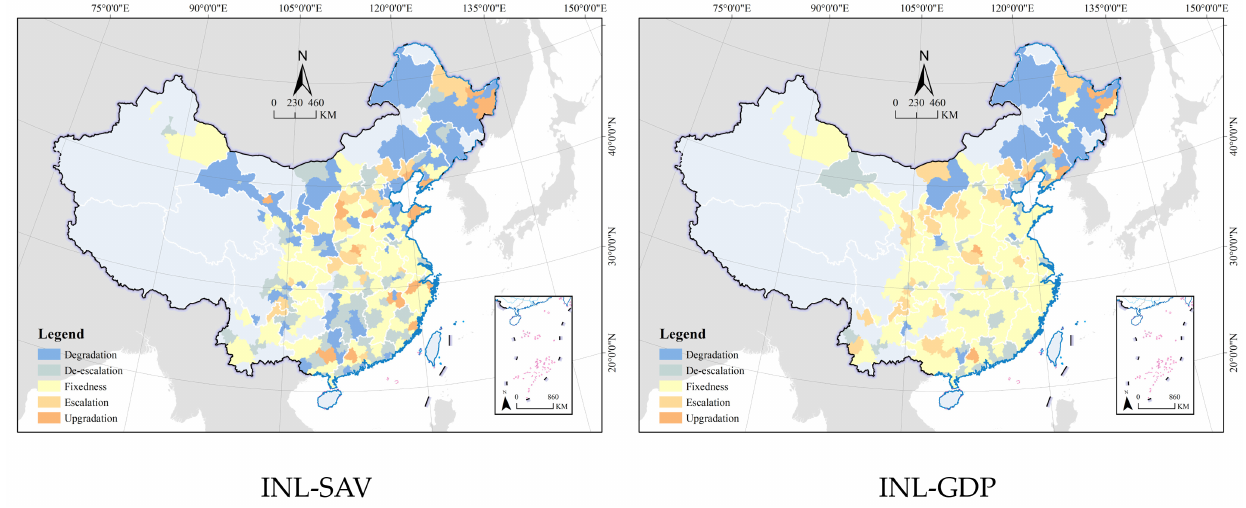
Figure 8. Distribution of decoupling changes between industrial land and economic